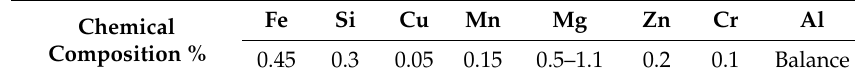
Table 2. Chemical properties of the EN AW 5005 aluminum alloy [20].